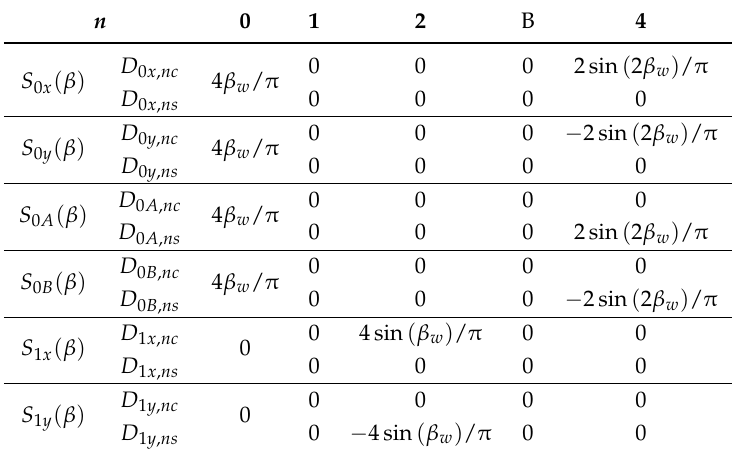
Table 7. Fourier coefficients of S i ( β ) for the electrode arrangement of